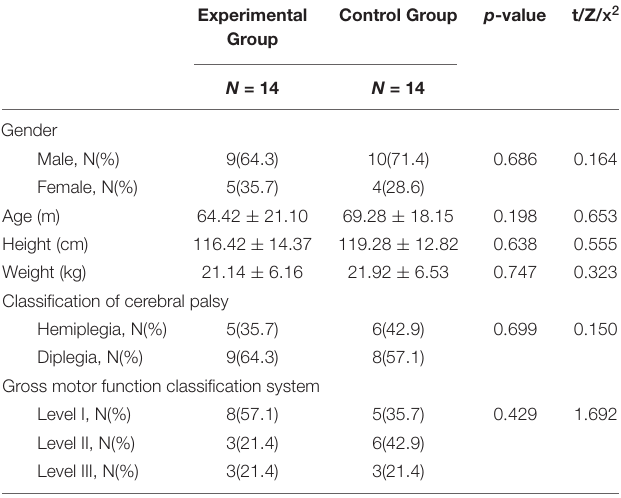
TABLE 1 | Descriptive characteristics of